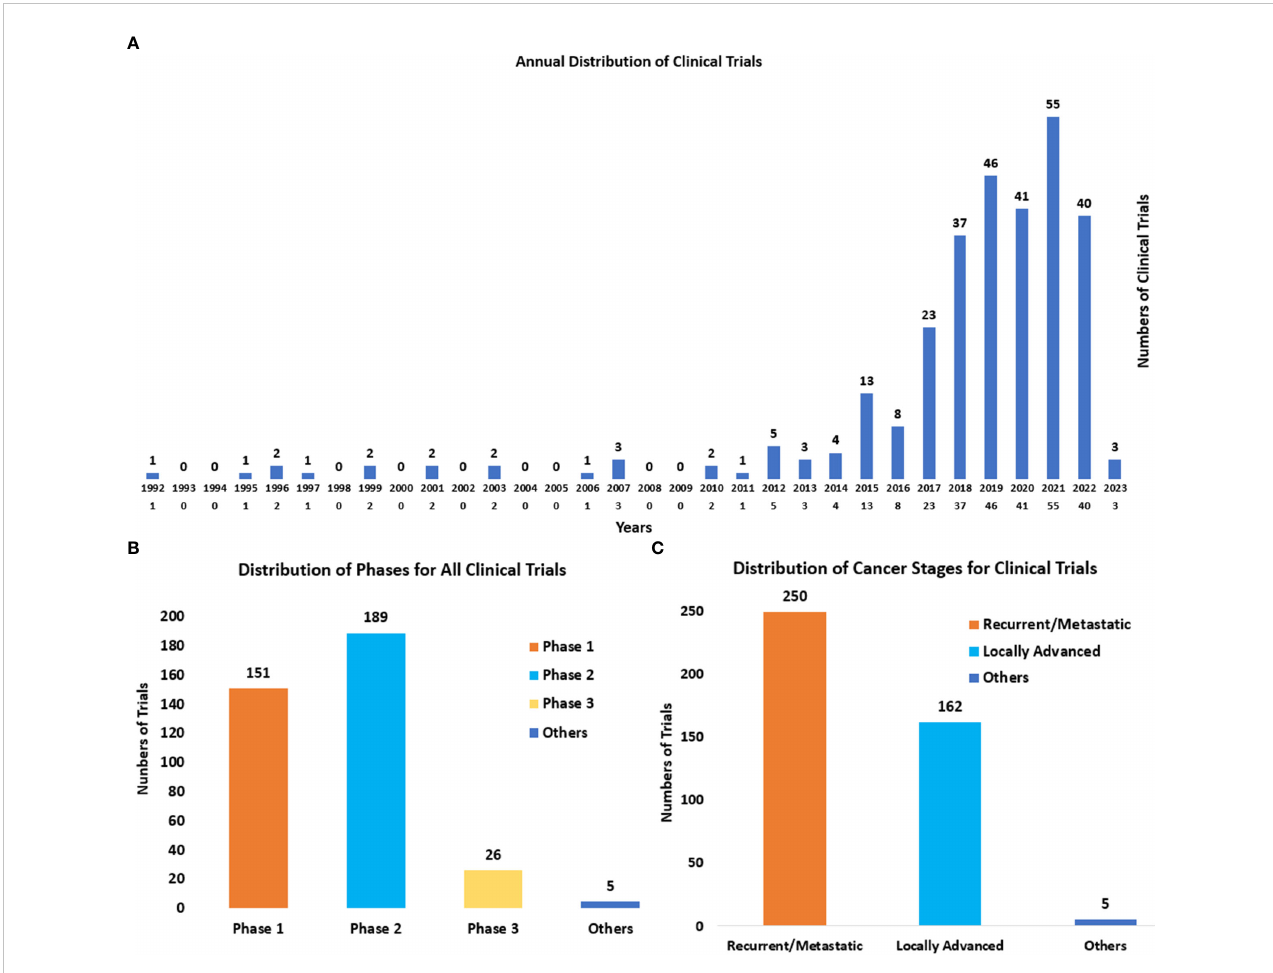
FIGURE 5 (A) The annual distribution of clinical trials from 1992 to 2023. The start date was regarded as the time of clinical trials. (B) The distribution of phases for all clinical trials. Others refer to the trials without known phases. (C) The distribution of cancer stages (recurrent/metastatic and locally advanced) for cervical cancer. Others mainly refer to early cervical cancers (stages IA1-IB2 and